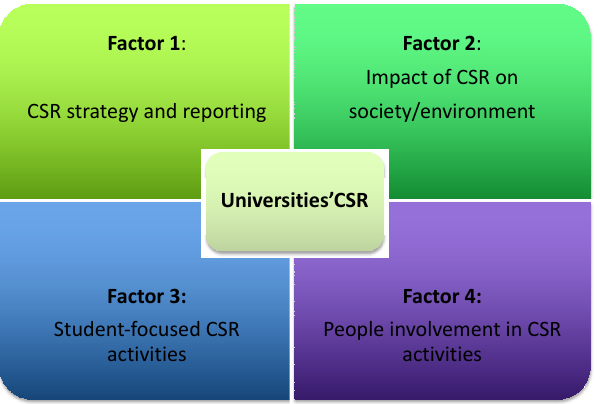
Figure 1. Factor analysis for CSR strategies and practices by universities according to the framework by Antonaras et al. (2018).